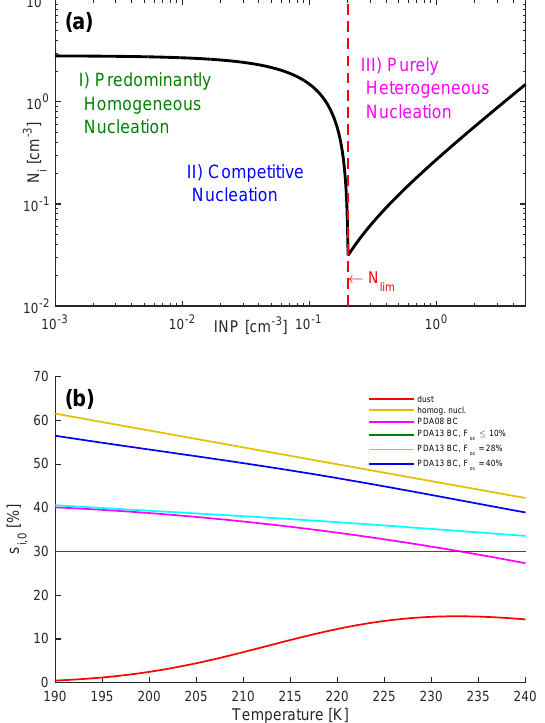
Figure 1. (a) Nucleation regimes of cirrus in the log-log INP-ice crystal number space. At low INP numbers, nucleation is predom- inantly homogeneous. At intermediate INP numbers, nucleation is competitive between homogeneous and heterogeneous. Beyond the threshold INP number, N lim , nucleation is purely heterogeneous; (b) threshold supersaturations for homogeneous nucleation and het- erogeneous nucleation on mineral dust and BC with different or- ganic coatings, F OC between 190 and 240K for the PDA08 and PDA13 nucleation spectra. Both use the same correlation for dust.